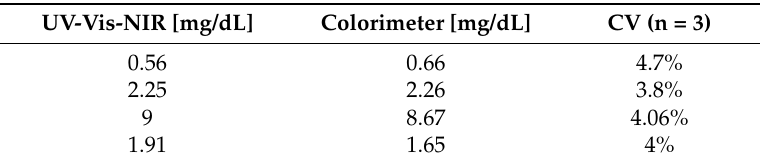
Table 2. Validation of samples with the reference method.